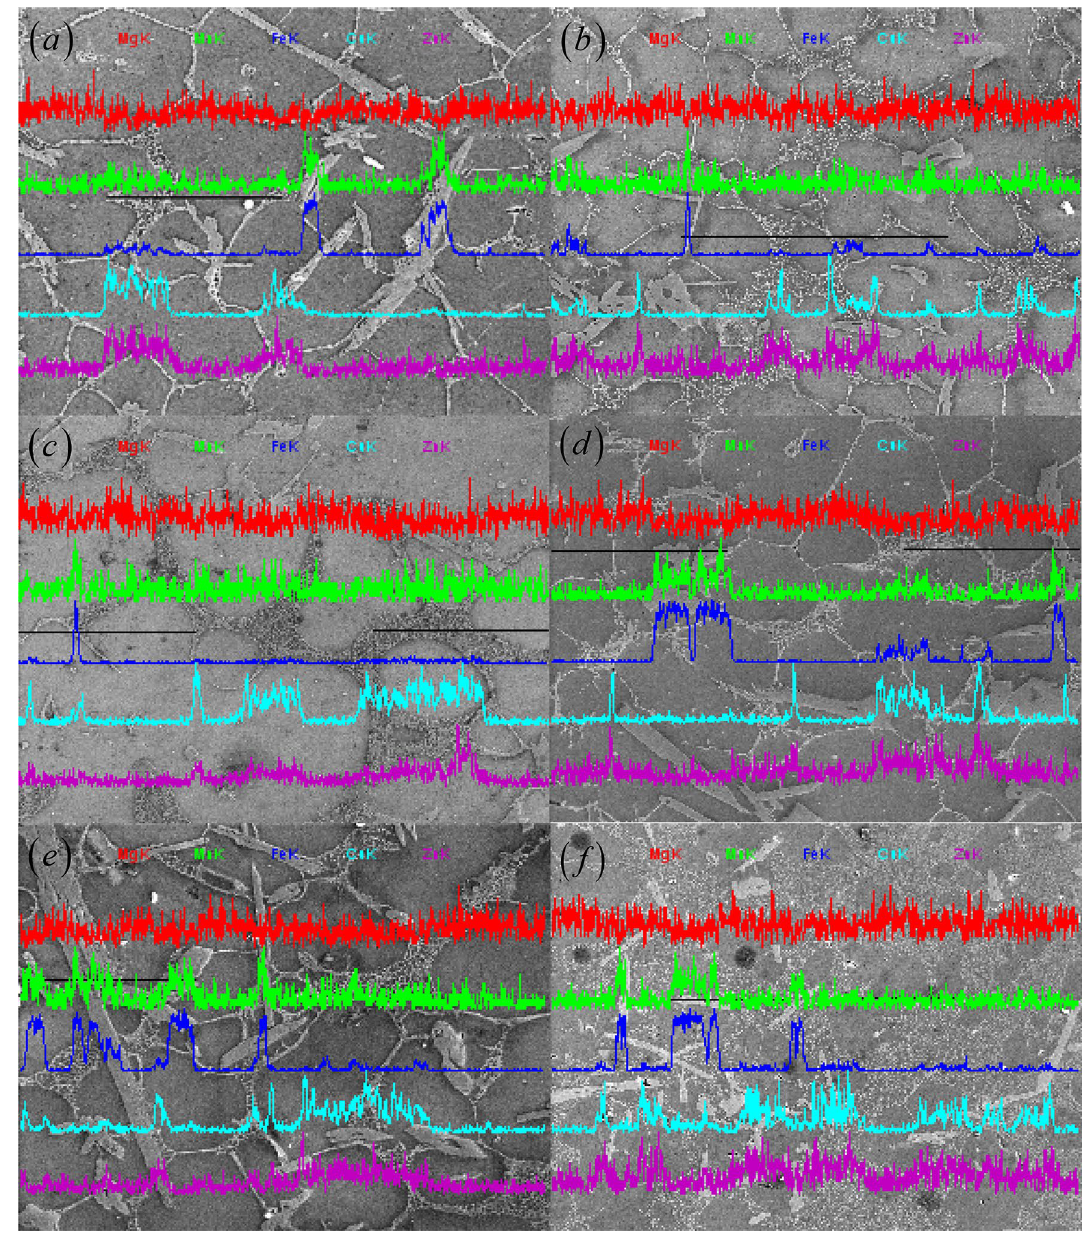
Figure 5. EDS analysis of Al–Fe–Cu alloy with isothermally held for 30 min at 640 °C ( a ), 630 °C ( b ), and 610 °C ( c ), and at 630 °C for 5 min ( d ), 15 min ( e ), and 60 min ( f